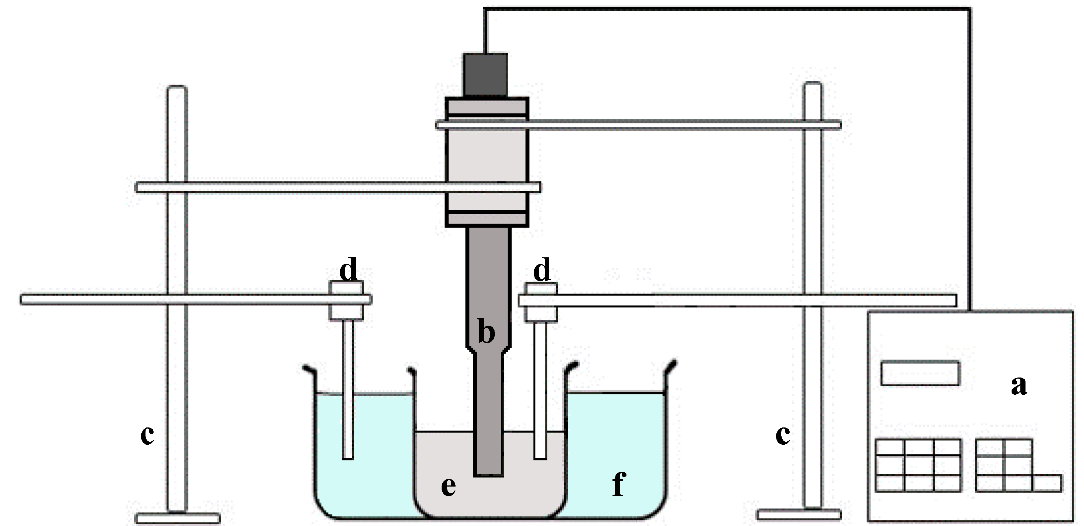
Figure 1. Experimental setup for direct thermosonic-assisted extraction. ( a ) Ultrasonic processor, ( b ) sonicator probe, ( c ) retort stand, ( d ) temperature probe, ( e ) fruit juice, and ( f ) water for controlling temperature.